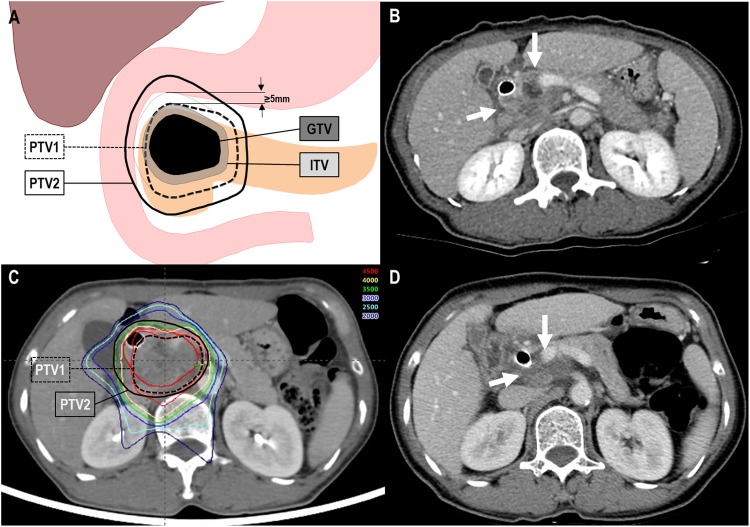
Partial response (PR) of a primary tumor to simultaneous integrated boost-proton beam
therapy (SIB-PBT). (A) Definition of target volumes depending on the proximity of
gastrointestinal structures, (B) pretreatment CT scans showing the primary tumor
(arrow), (C) the patient underwent SIB-PBT, and (D) CT scans 3 months after SIB-PBT
demonstrating PR of the primary tumor (arrow). CT indicates computed tomography; GTV,
gross tumor volume; ITV, internal target volume; PTV, planning target volume.